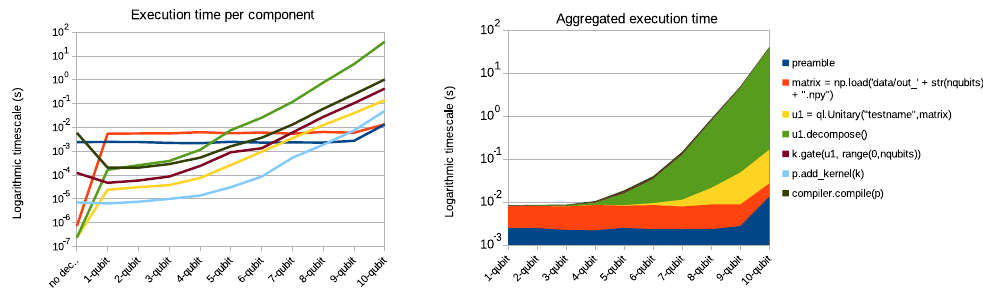
Figure 13. Execution time for the timed intervals, for different sizes of unitary matrices.